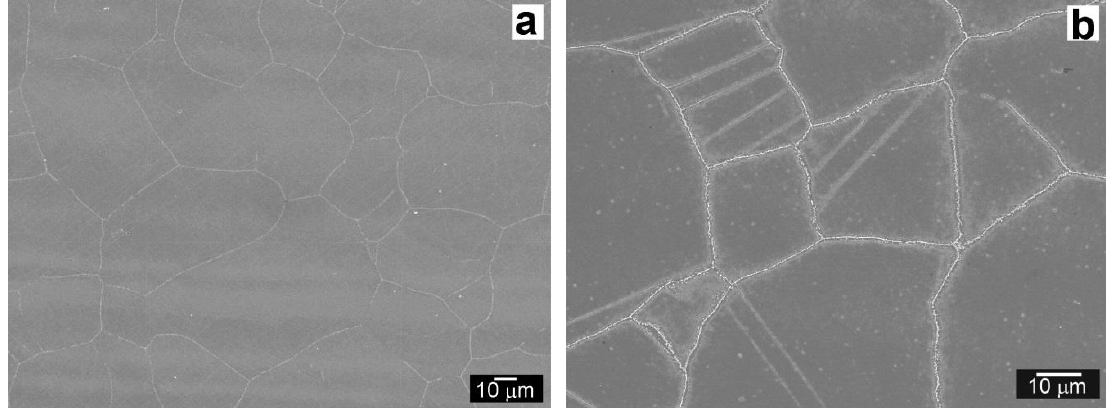
Figure 5 . Microstructure of the Ni WM near T92 BM/Ni WM interface: Type-II boundary in initial QT PWHT material state ( a ); and migrating Type-II boundary observed after 620 °C/2500 h of thermal aging ( b ).